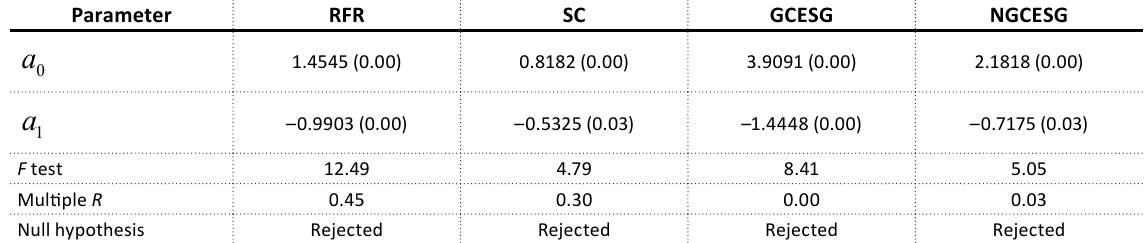
Table C4. Regression analysis with dummy variables of the differences between developed countries and developing and emerging countries* Parameter RFR SC GCESG NGCESG